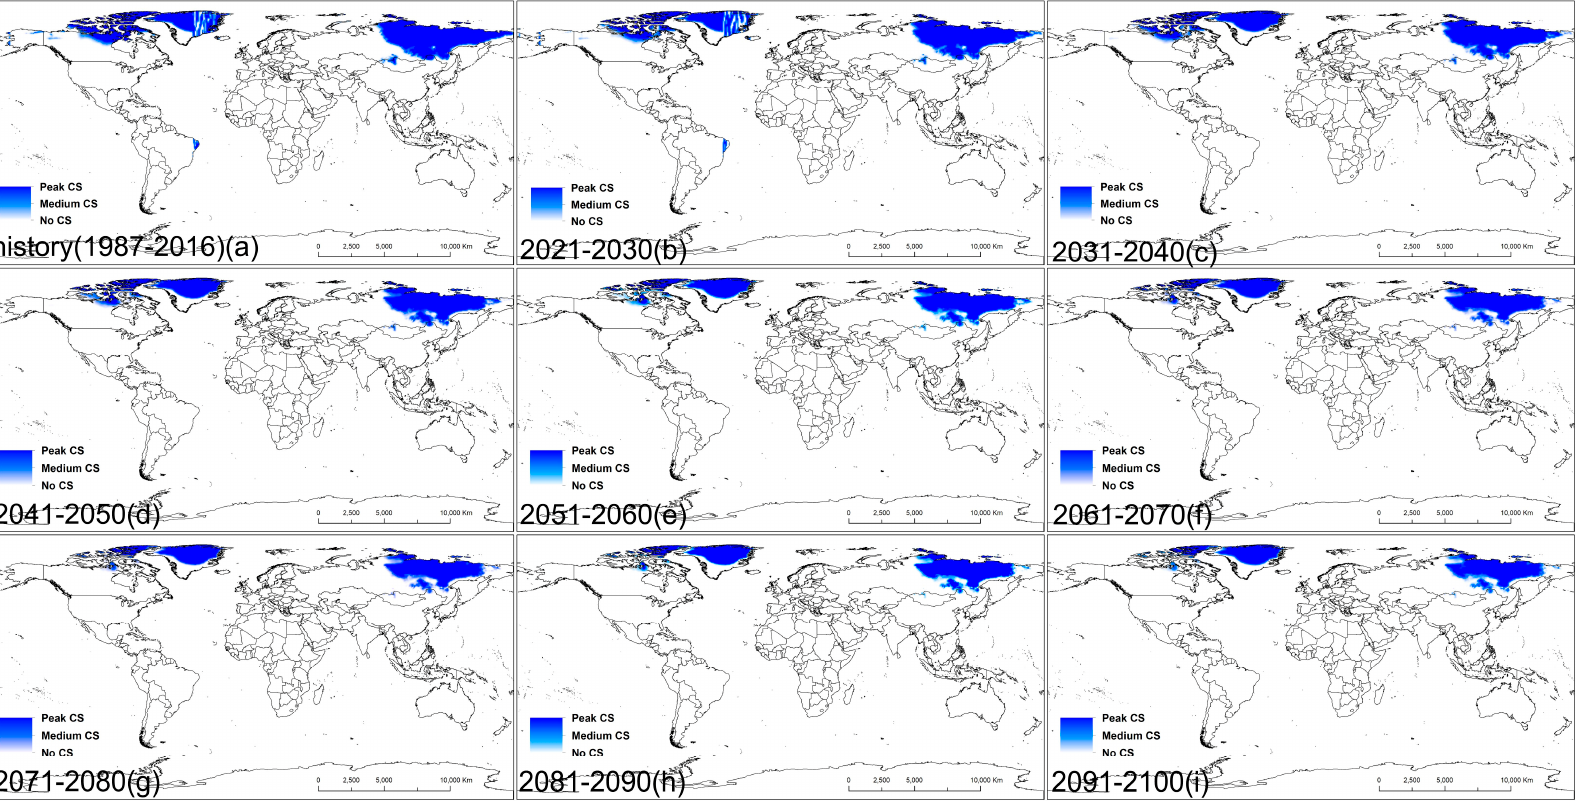
Figure B1. Distribution of cold stress (CS) for D. ponderosae under historical (1987–2016) and future (2021–2100) climate conditions. ( a ) Historical and ( b – i ) future data. The intensity of the blue color indicates the degree of CS (deep blue represents peak CS, white represents no CS).